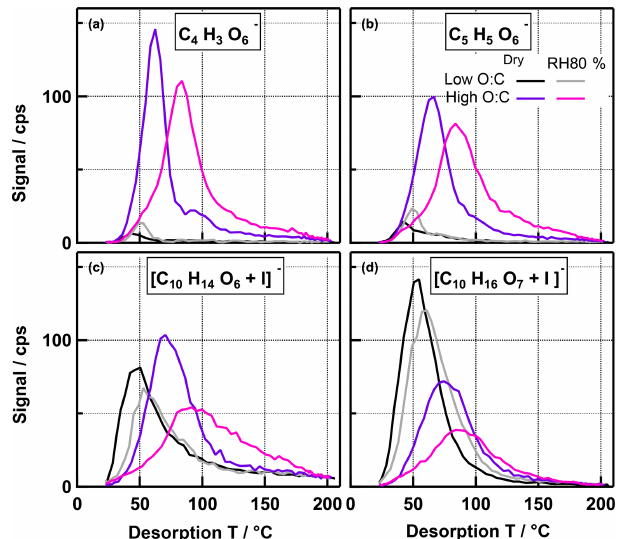
Figure 4. Non-normalized thermograms for four single ions for low- and high-O : C cases. Ions in panels (a) , (b) , and (c) showed a net increase in the RH80% case, while the ion in panel (d ) had a net decrease in the high-O : C ratio case. Note that the amount of SOA mass collected on the FIGAERO filter was 5%–20% higher in the RH80% cases and is also different between the O : C